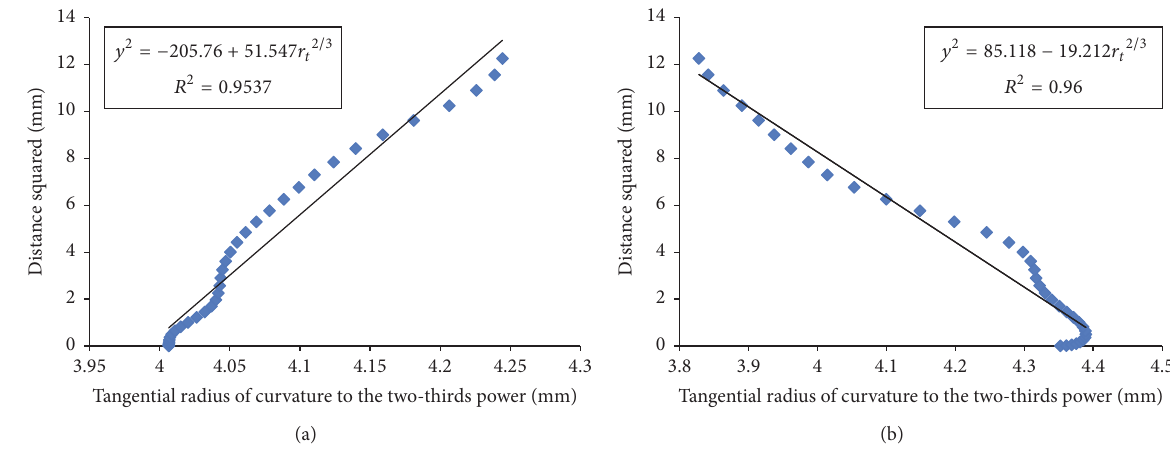
Figure 1: Scatterplot of distance squared ( 𝑦 2 ) versus tangential radius of curvature to the two-thirds power ( 𝑟 𝑡2/3 ) in the nasal flat principal semimeridian of the right eye for subject number one before (a) and after surgery (b).